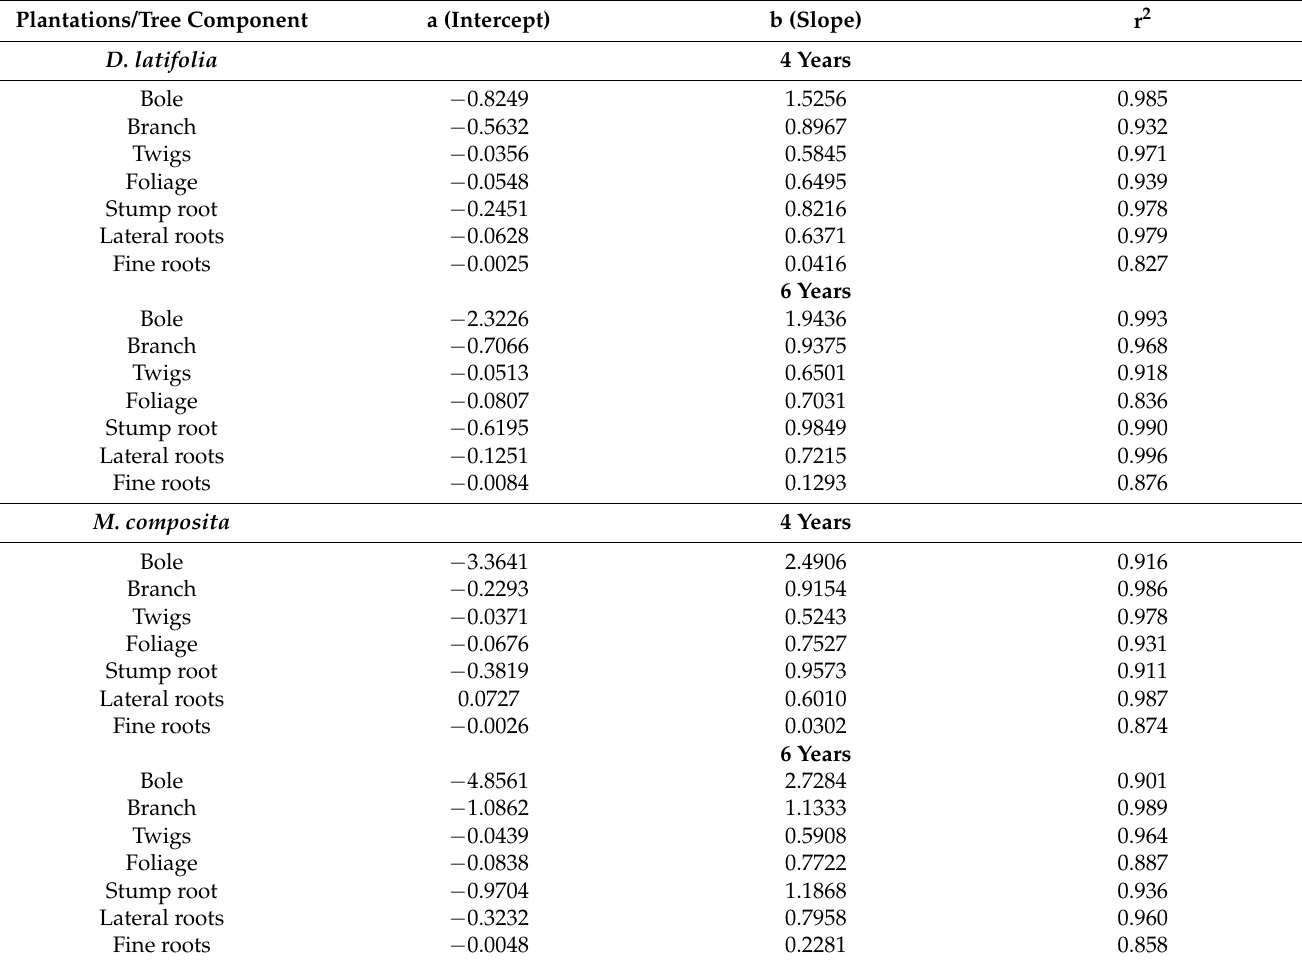
Table 2. Regression equation relationship between the biomass of the tree components (y, kg tree − 1 ) and diameter at breast height (X, cm) for plantations of D. latifolia and M. composita in 4- and 6-year-old plantations. All regression equations had good fit ( p <